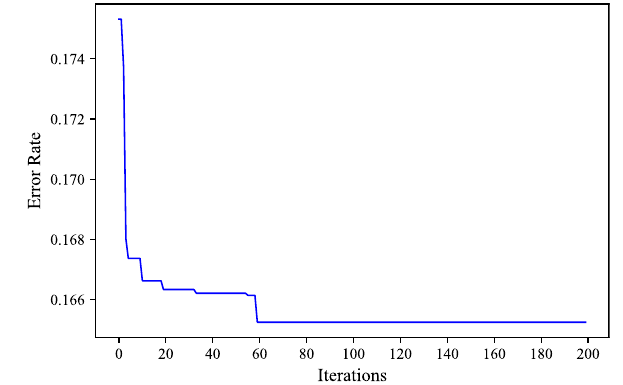
Fig. 6 Parameter optimization iteration of PSO-XGBoost